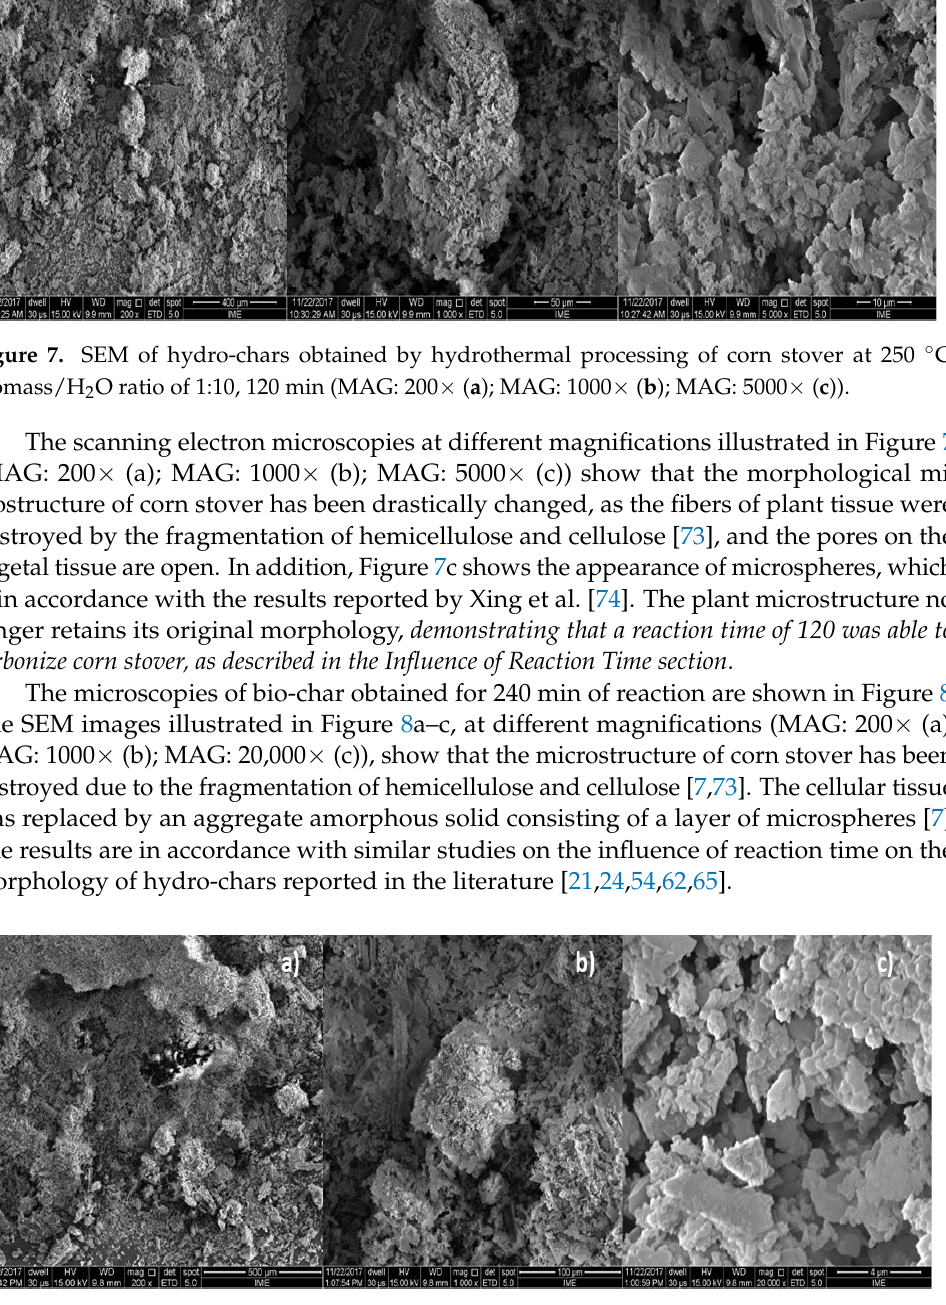
Figure 6. SEM of hydro-chars obtained by hydrothermal processing of corn stover at 250 °C, a bio- mass/H 2 O ratio of 1:10 and 60 min (MAG: 200× ( a ); MAG: 1000× ( b ); MAG: 5000× ( c )).